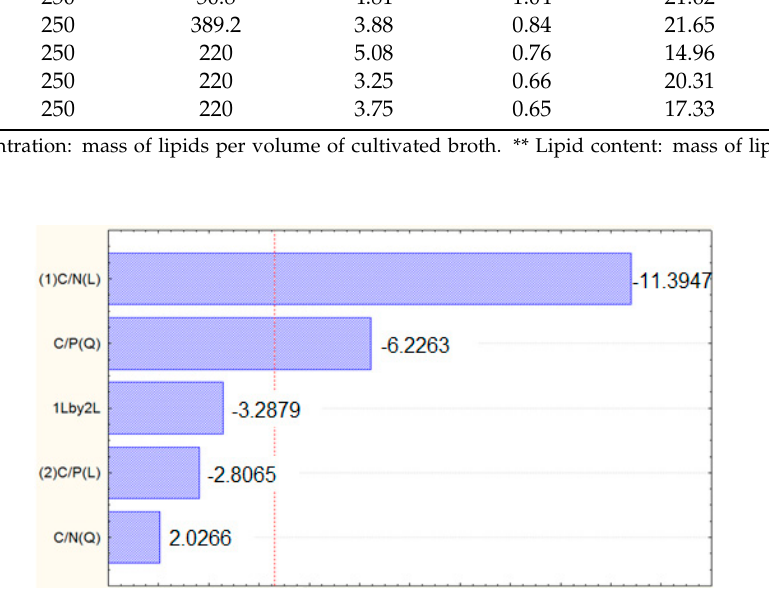
Figure 2. Pareto chart for cultivations with R. toruloides at different C/N and C/P ratios. Standardized effect estimate (absolute values, p = 0.05).